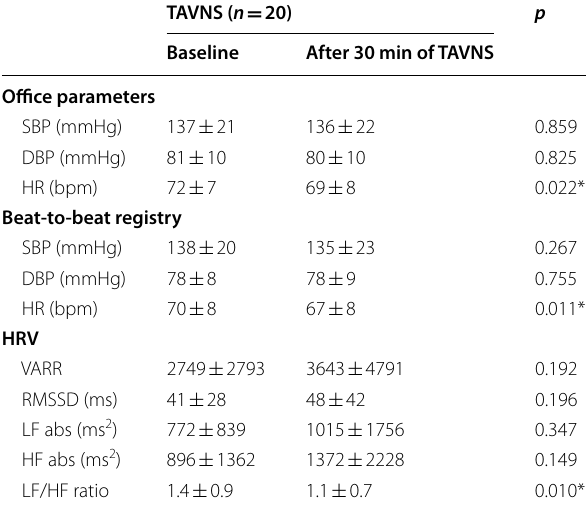
Table 1 Baseline clinical and fasting laboratory profile of patients in control and the TAVNS groups at baseline